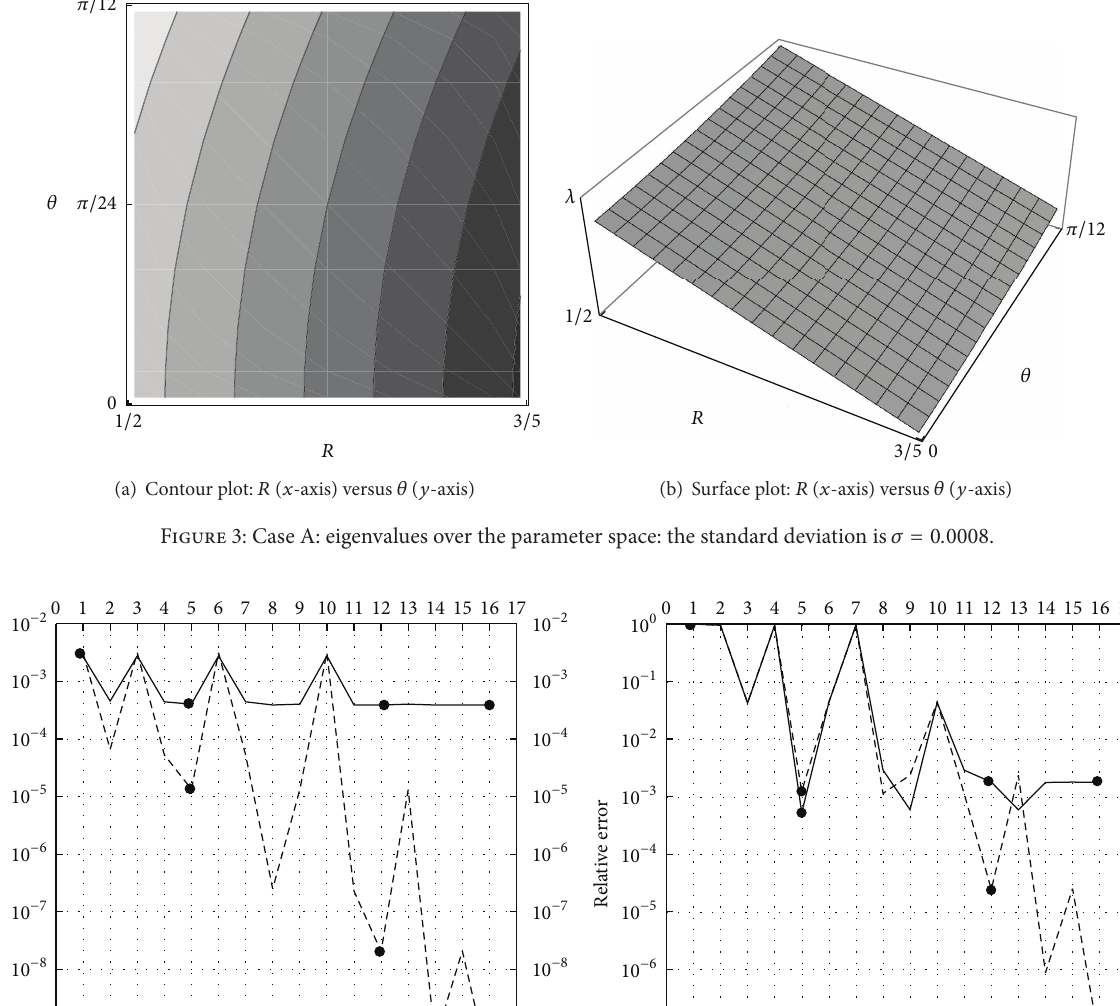
rate of 𝑠 = − 1 . 5. We set the truncation parameter to be 𝑀 =